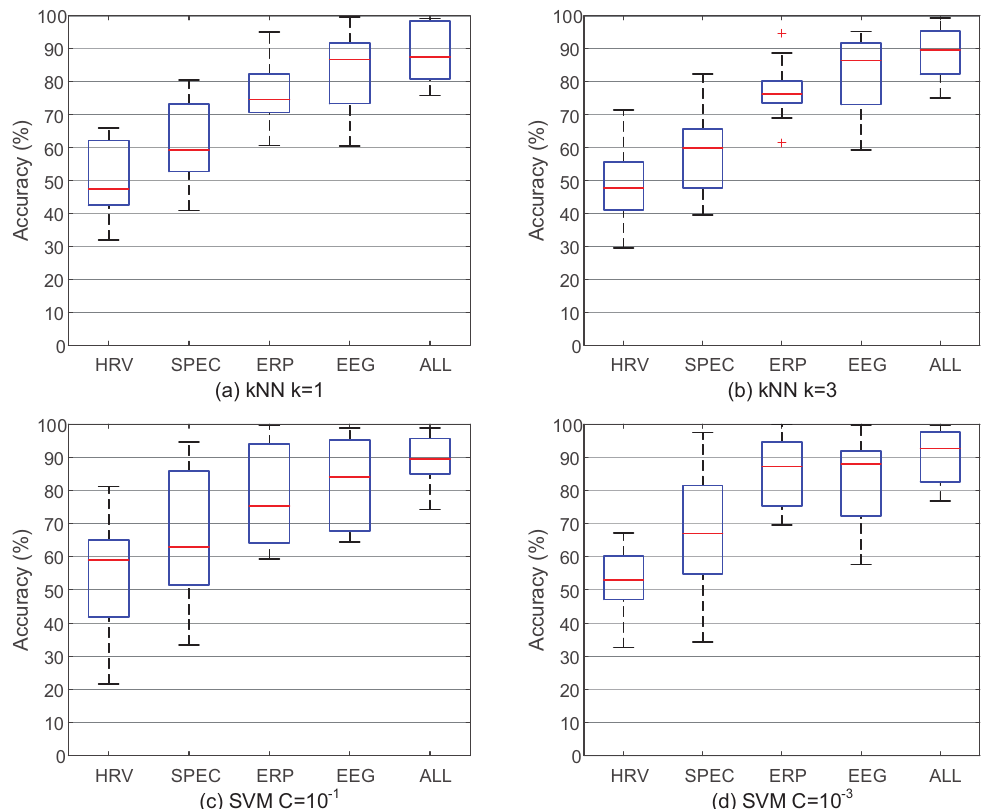
Figure 7. The performance of IMIM-F between the single feature vectors and the fused feature vectors based on different classifiers. k-NN and SVM classifiers are chosen to validate the necessity of signal fusion.